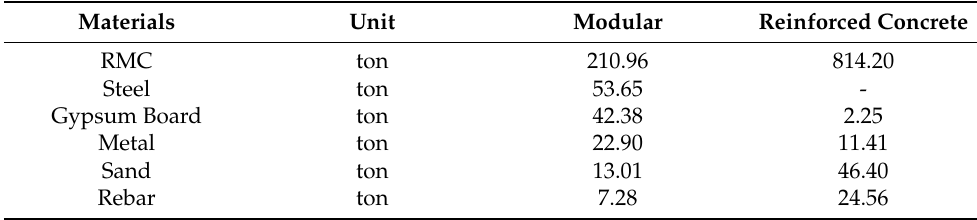
Table 2. Quantity of major construction material using the two building systems.